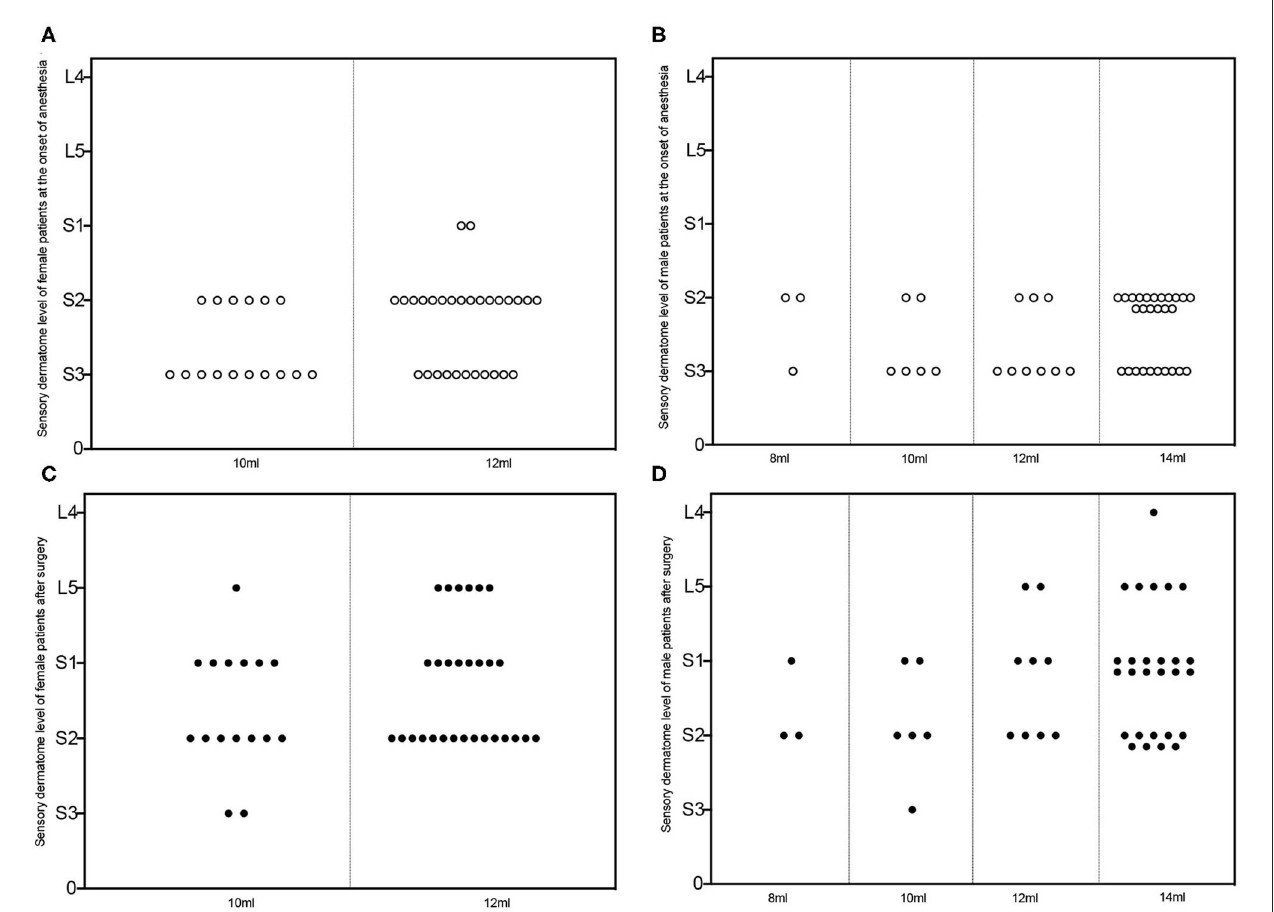
FIGURE4 Sensory dermatome level of patients subjected to successful caudal block. Sensory dermatome levels of female (A, C) and male (B, D) patients administrated with different volumes of ropivacaine at the onset of the caudal block (hollow circle in A, B ) and the end of surgery (solid circle in C, D ). L, lumbar segment; S, sacral